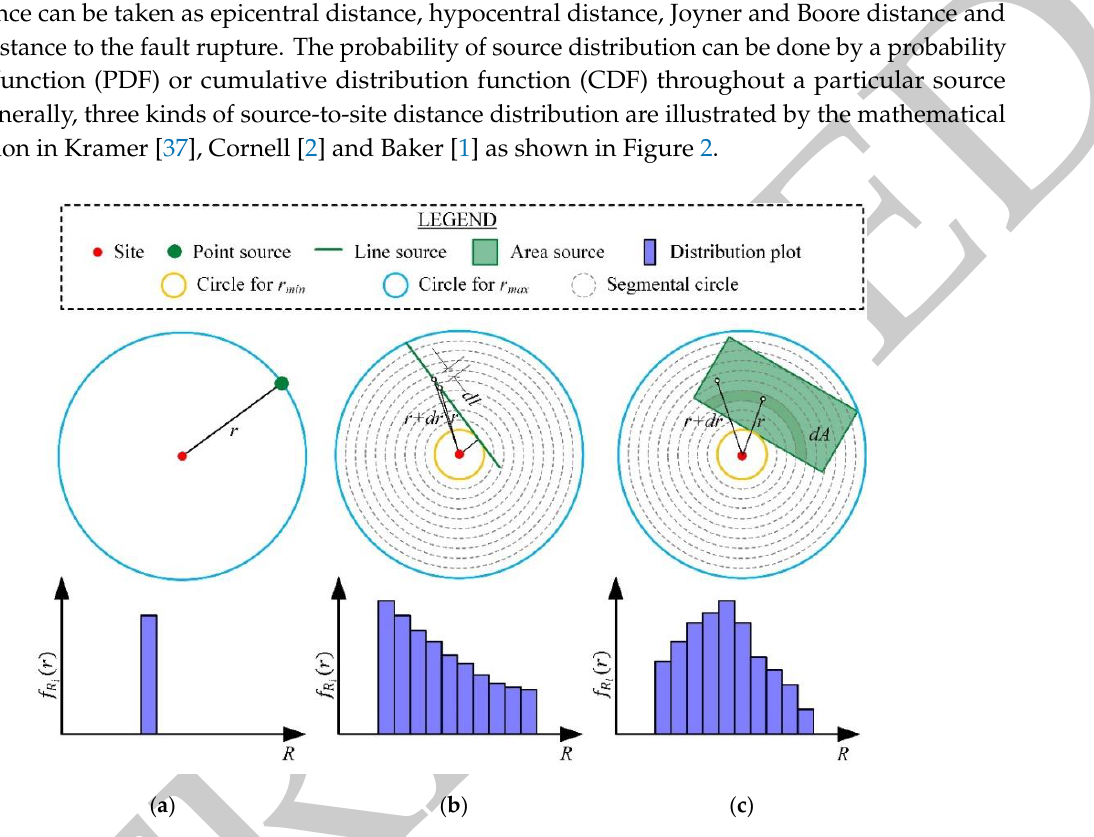
Figure 2. Examples of source-to-site distance for different source geometries and probability distribution: ( a ) Point source, ( b ) Line source, ( c ) Area source.